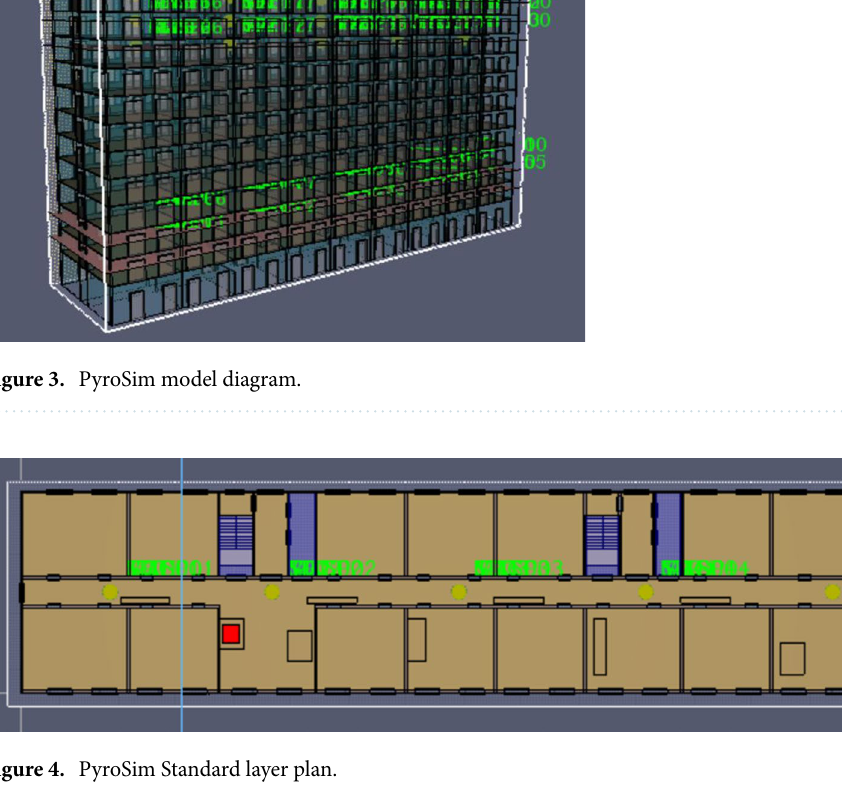
Figure 4. PyroSim Standard layer